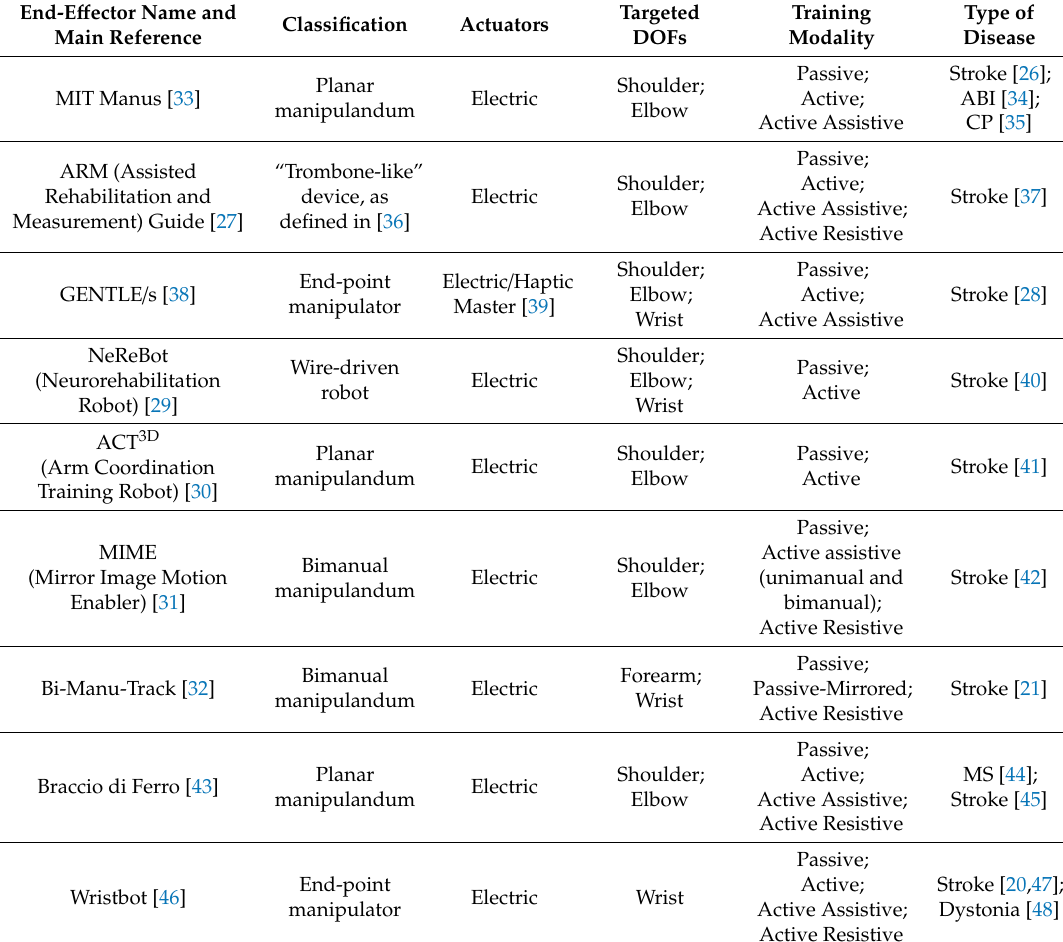
Table 1. Main features of the most common upper limbs end-e ff ector rehabilitation